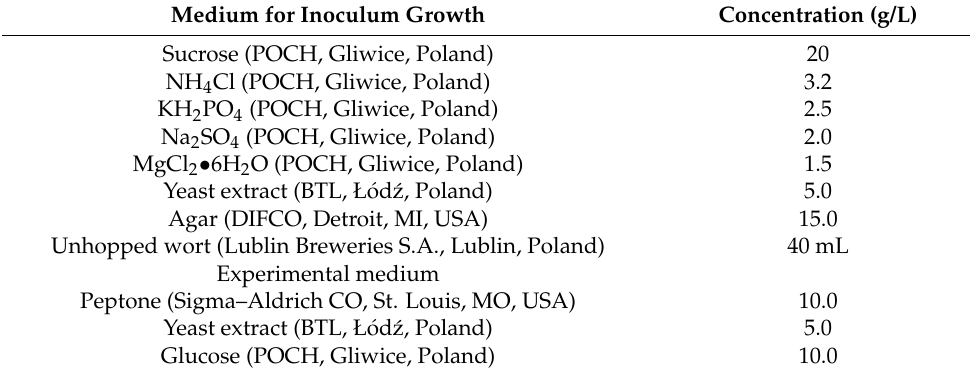
Table 3. The composition of media used in the